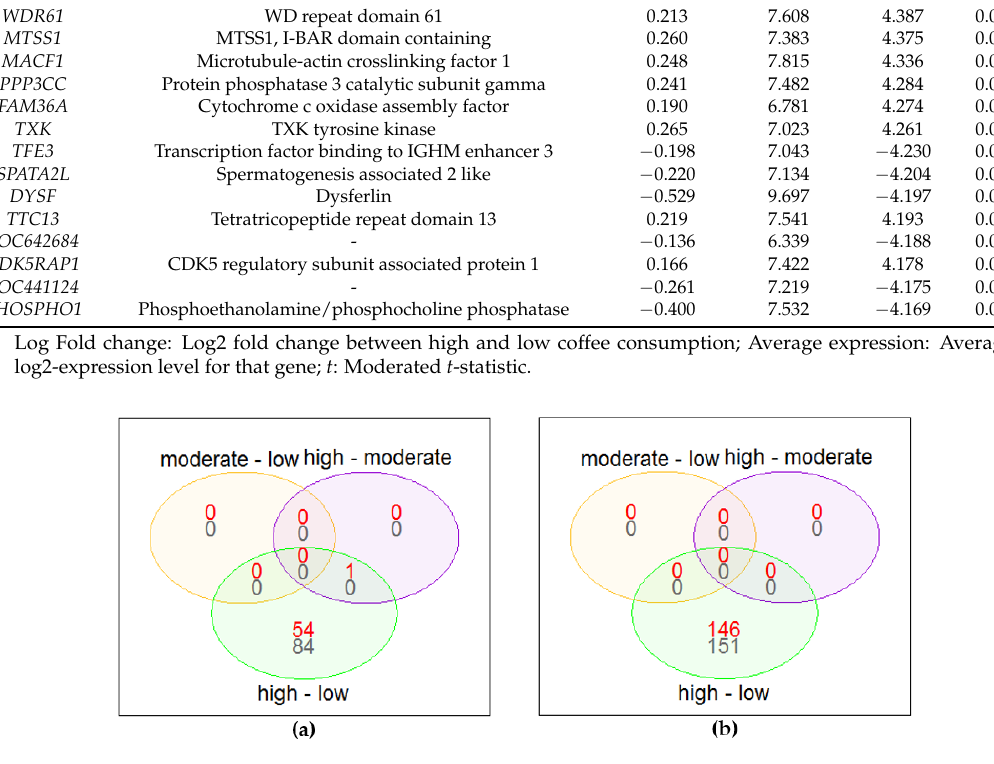
Figure 2. ( a ) Significantly up-(red) and down-(grey) regulated genes between coffee consumption categories for “all women.” ( b ) Significantly up-(red) and down-(grey) regulated genes between coffee consumption categories for “low tea, nonsmokers.” Table 3. Top 20 significantly differentially expressed genes (false discovery rate < 0.05) between high and low coffee consumers in the “low tea, nonsmoking” group.